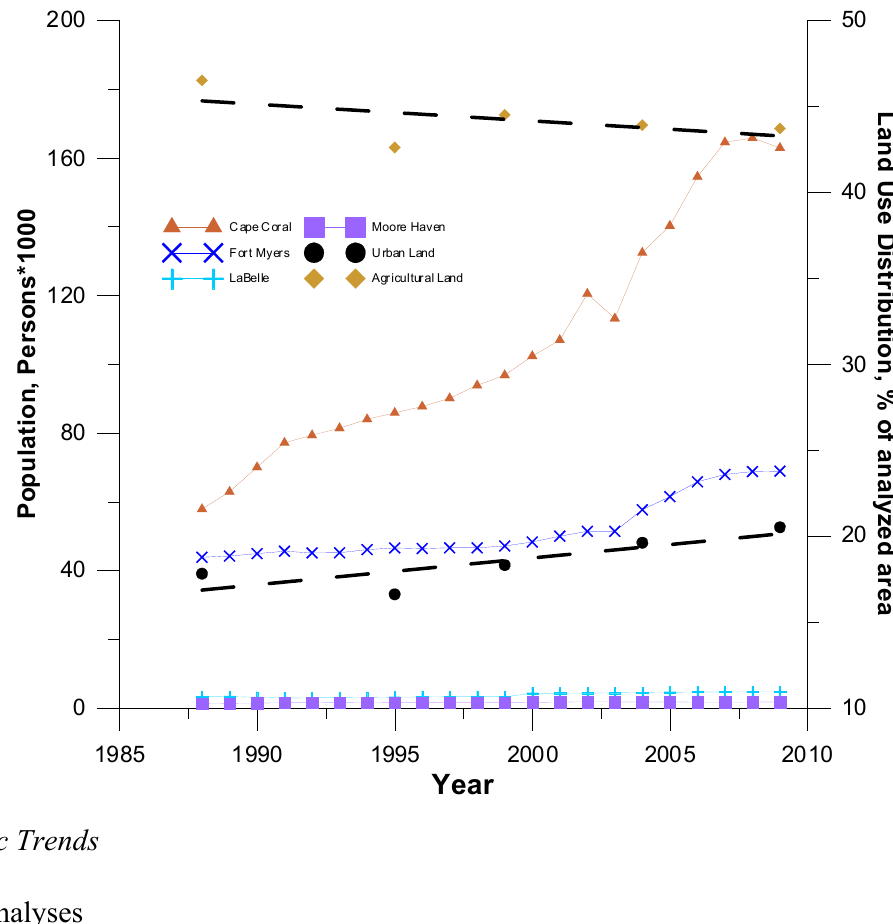
Figure 5. Populations in the various urban centers in the watershed along with proportions of urban and agricultural land uses in the